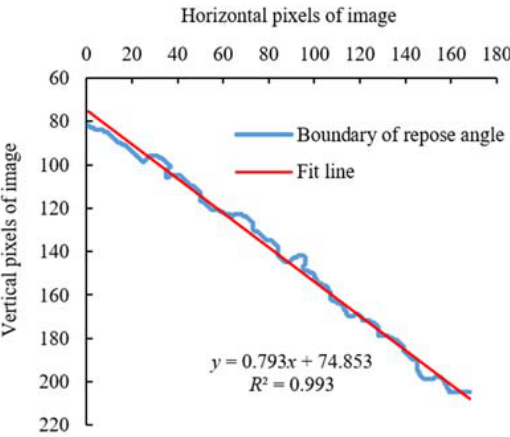
Figure 5. Boundary fitting curve of dynamic repose angle.